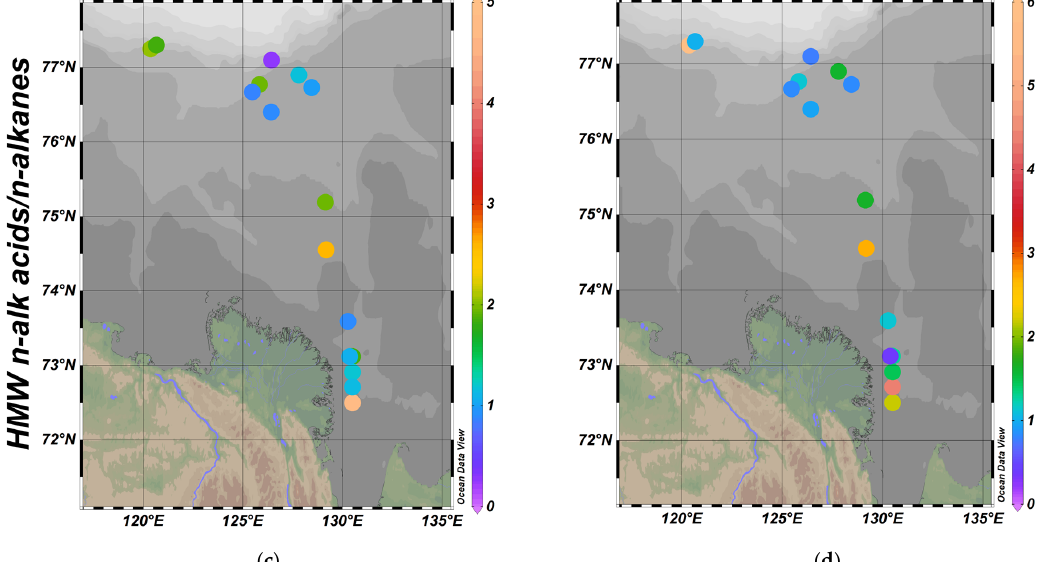
Figure 5. Distribution of molecular ratios for LS surface sediments: high molecular weight (HMW) n-alkanes carbon preference index (CPI; a , b ); HMW n-alkanoic acids/HMW n-alkanes ( c , d ). Figure 5a,c show values